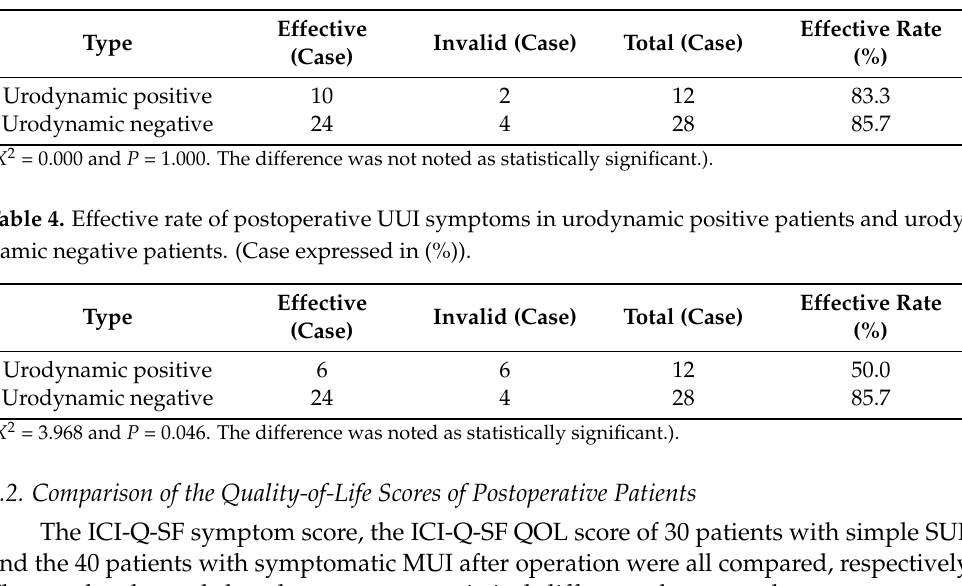
Table 3. Effective rate of postoperative SUI symptoms in patients with positive urodynamics and patients with negative urodynamics. (Case expressed in (%)).